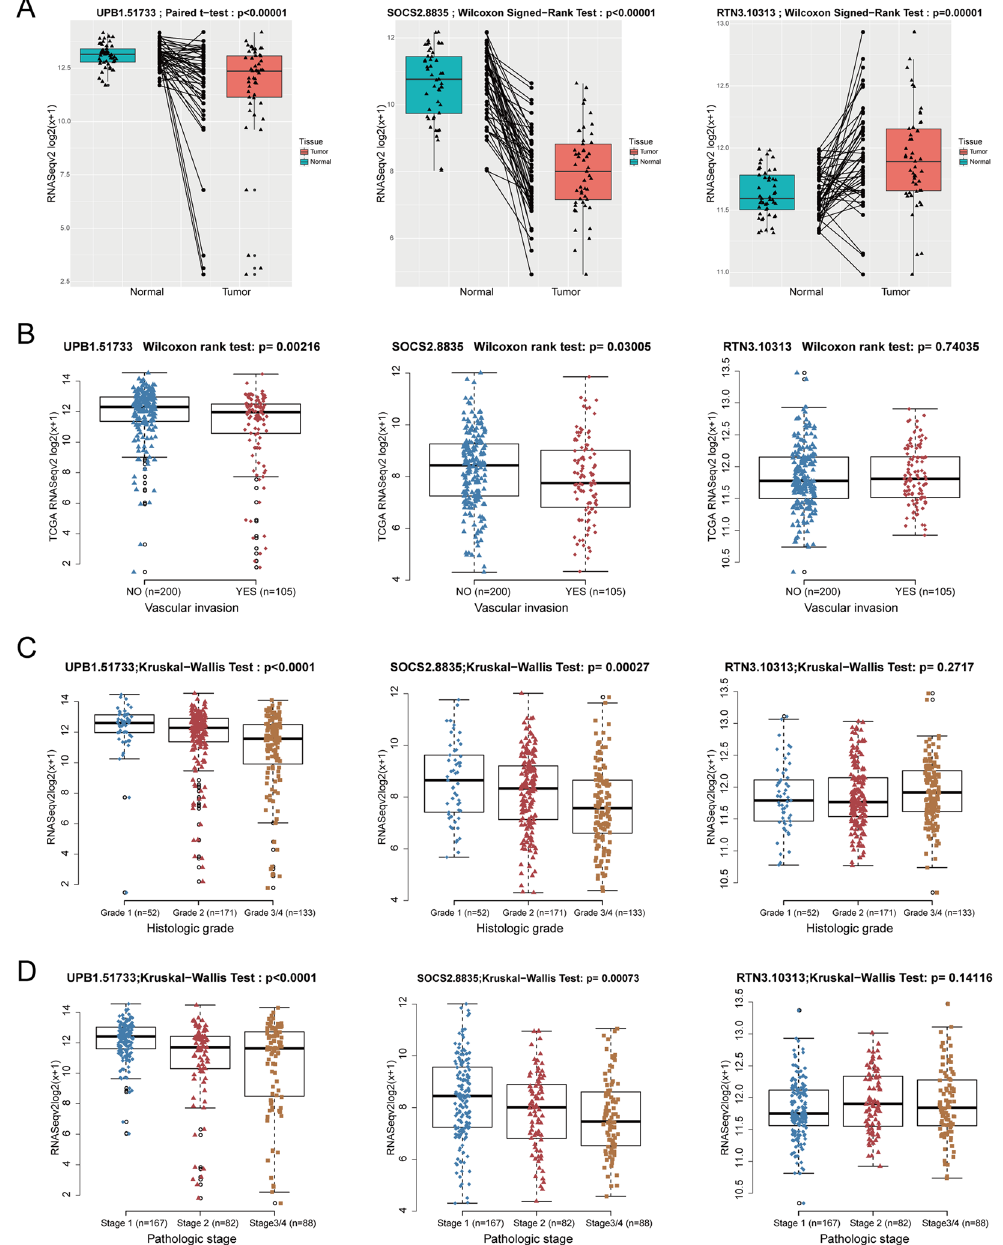
Figure 5. Functional analysis of prognostic genes UPB1, SOCS2, and RTN3 using TCGA dataset. ( A ) The expression pattern of UPB1 (left panel), SOCS2 (middle panel), and RTN3 (right panel) in 49 HCC tissues and paired adjacent non-tumor tissues from TCGA dataset. The Shapiro-Wilk test was applied to determine whether data followed a normal distribution. The paired t-test was applied to normally distributed data otherwise the Wilcoxon rank test for paired data was applied to assess the expression pattern in HCC tissues. UPB1 and SOCS2 were downregulated in HCC tissues, while RTN3 was upregulated. ( B ) Association of UPB1 (left panel), SOCS2 (middle panel), and RTN3 (right panel) expression with vascular invasion. Mann- Whitney-Wilcoxon test showed significant differences between vascular invasion group (n = 200) and no vascular invasion group (n = 105) of UPB1 and SOCS2 expression, but not RTN3. ( C ) Association of UPB1 (left panel), SOCS2 (middle panel), and RTN3 (right panel) expression with the histologic grade. 356 patients with histologic grade information (grade 1, n = 52; grade 2, n = 171; grade 3/4, n = 133) were recruited for the analysis. The Kruskal-Wallis test revealed a negative correlation between UPB1 and SOCS2 expression and histologic grade, while no significant differences was found in RTN3 expression in different groups. ( D ) Association of UPB1 (left panel), SOCS2 (middle panel), and RTN3 (right panel) expression with pathologic stage. 337 patients with pathologic grade information (stage 1, n = 167; stage 2, n = 82; stage 3/4, n = 88) were recruited for the analysis. The Kruskal-Wallis test was performed. UPB1 and SOCS2 were found to be associated with pathologic stage, while RTN3 was